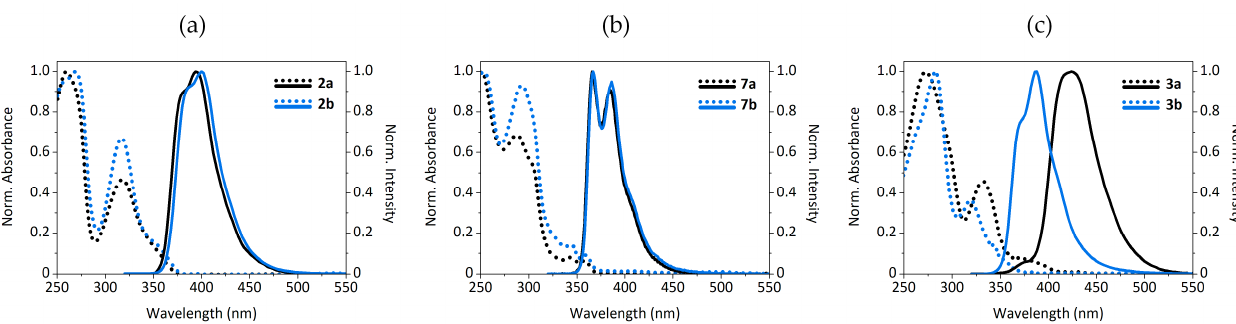
Figure 3. Absorption (pointed) and emission (solid, λ ex = 300 nm) spectra in CH 2 Cl 2 of compounds: ( a ) 2a – b ; ( b ) 7a – b ; ( c ) 3a – b .